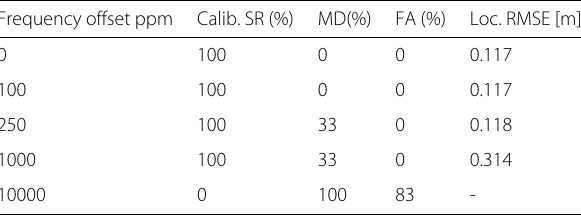
Table 5 Measures for various frequency offsets between